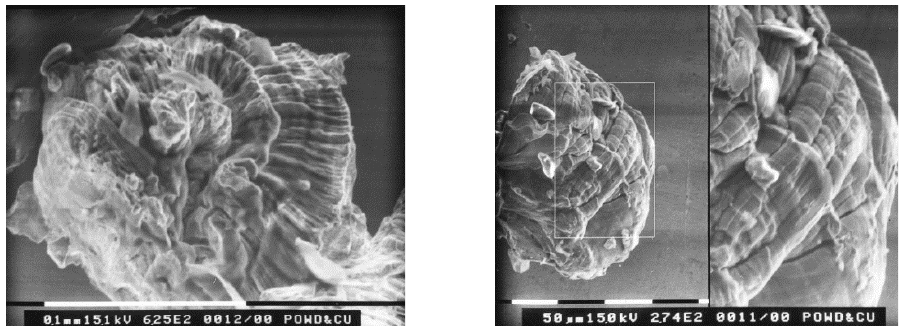
Figure 9. Relict crystallized mesoparticles with shear bands within spall zone. Of shock-deformed copper (chapter 4 [2]). copper (chapter 4